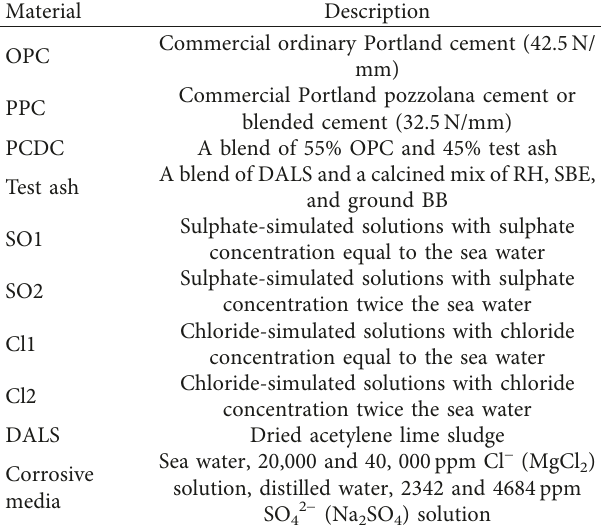
Table 1: Compositions of various materials used. Material